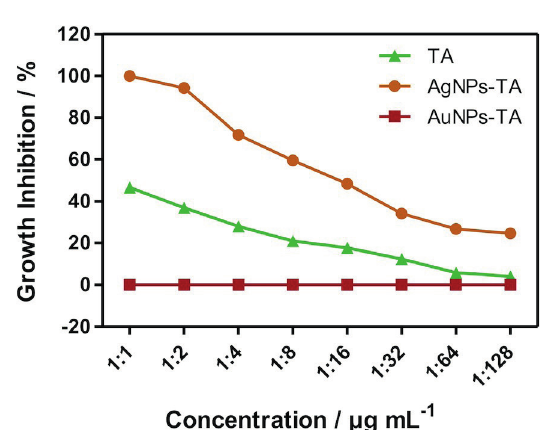
Figure 4 - Comparison of inhibitory effect between hybrid nanomaterials and TA